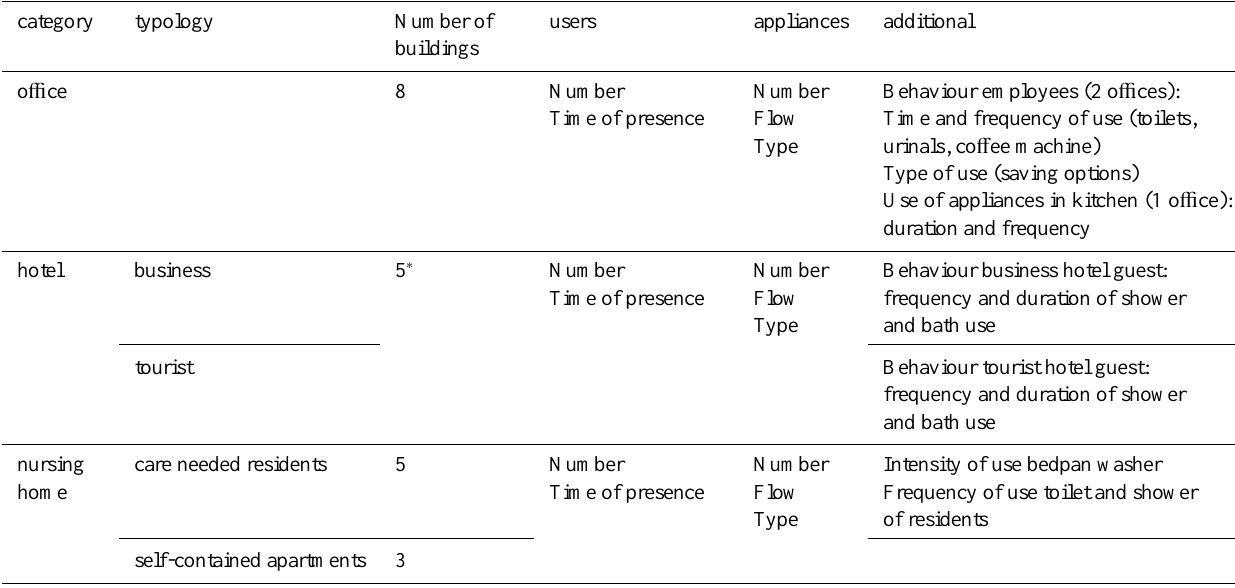
Table 7. Number of interviewed buildings in each category of non-residential buildings and the requested information in the surveys. category typology Number of